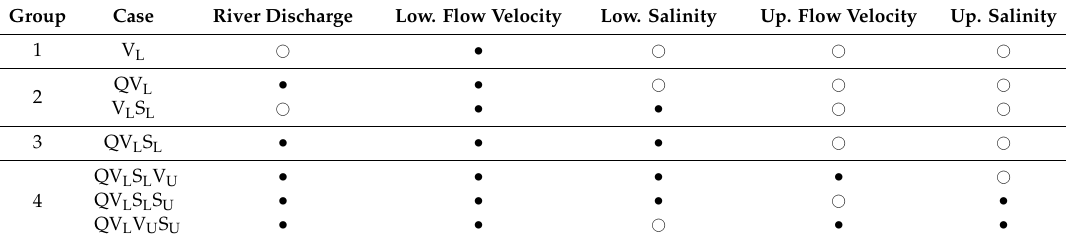
Table 2. Case of input data. Closed and open circles denote used and unused input data, respectively. Group